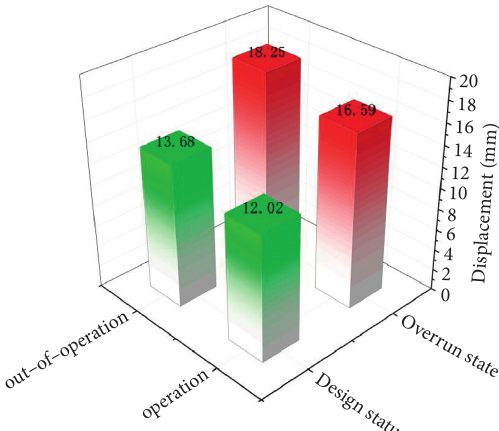
Figure 8: Deformation of the lattice columns in the vertical state and inclined state.